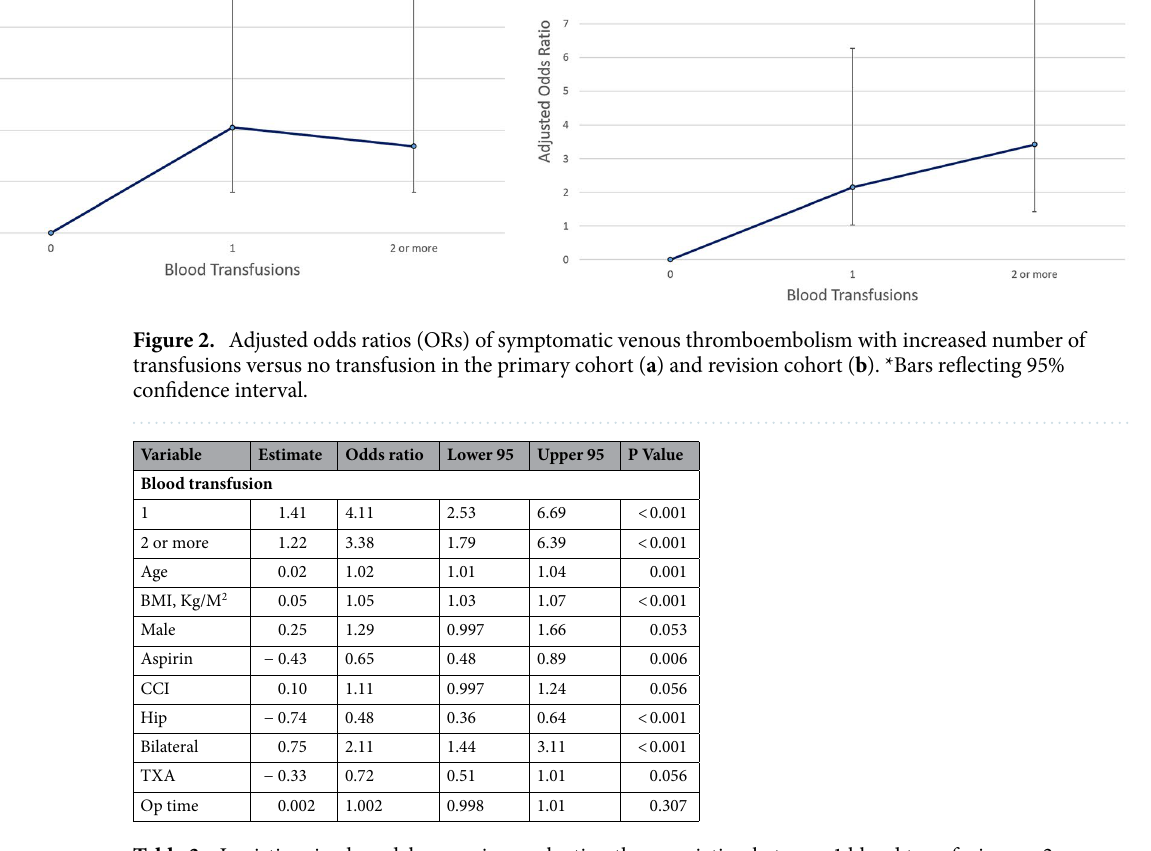
Table 3. Logistic mixed model regression evaluating the association between 1 blood transfusion, or 2 or more (with zero transfusions as the reference) and risk for VTE in the primary TJA cohort. BMI Body